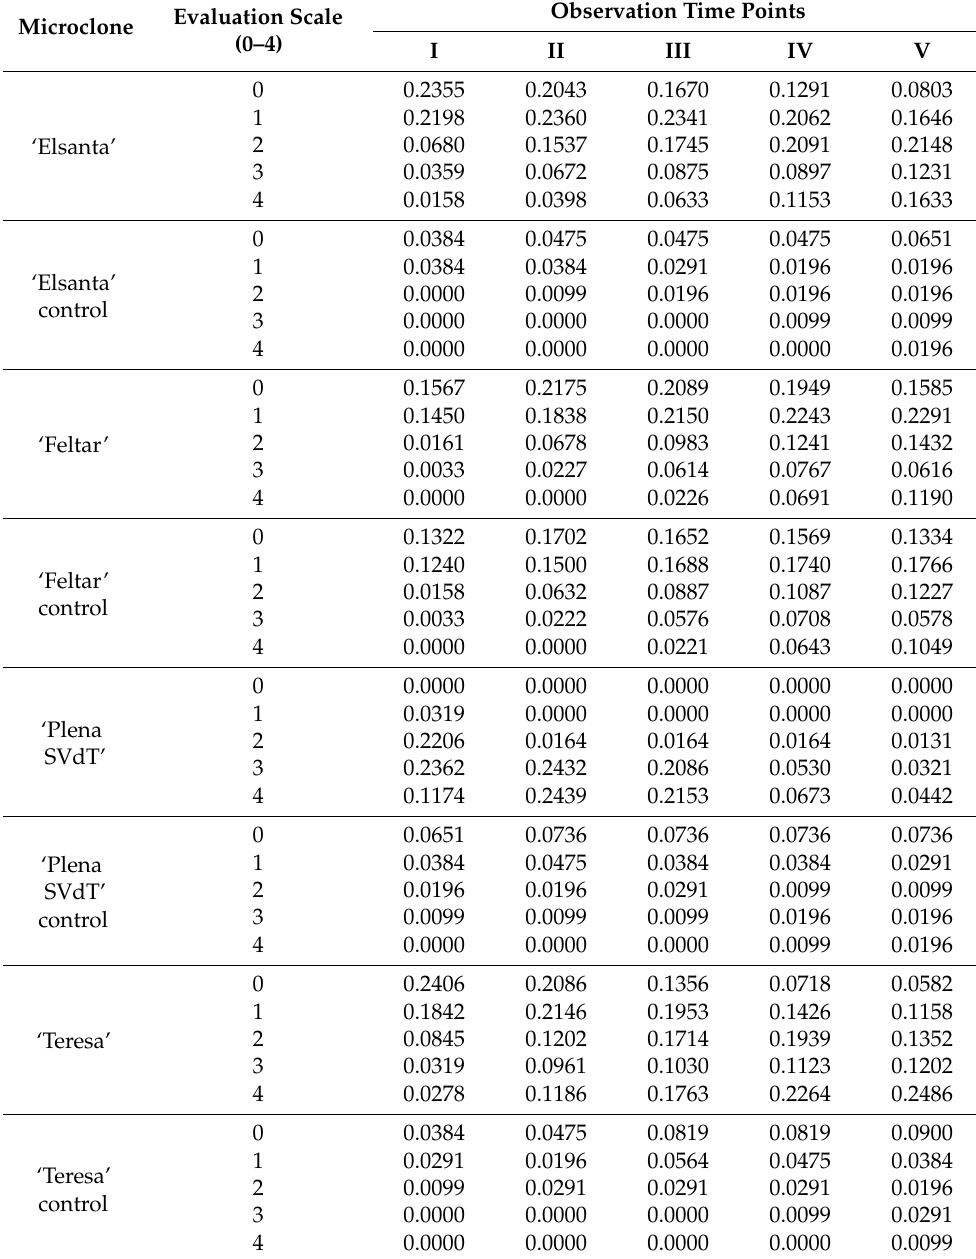
Table 6. Simmonds disease index at subsequent observation time points for P. cactorum —infected microclones and the control